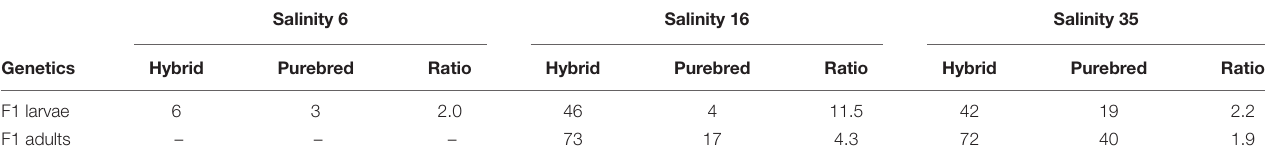
FIGURE 3 | Otolith growth of F1 larvae and adult purebred and hybrid herring reared at salinity of 16 or 35 psu. Mean increment width ± 95% confidence intervals are given for each 10 µ m interval. Data points are offset for visual clarity. TABLE 3 | Overview of the ratio between Atlantic purebreds and Atlantic/Baltic hybrids during the larval stage and as adults. Salinity 6 Salinity 16 Salinity